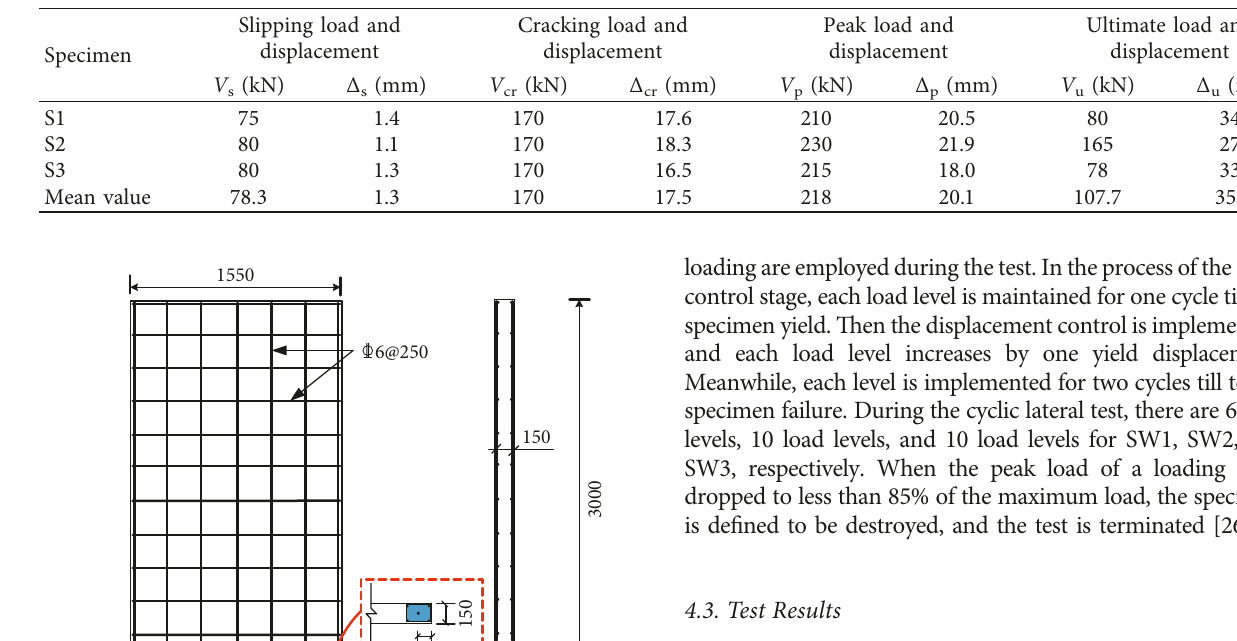
Figure 10: Shear load versus displacement curve. Table 2: Results of the shear test.